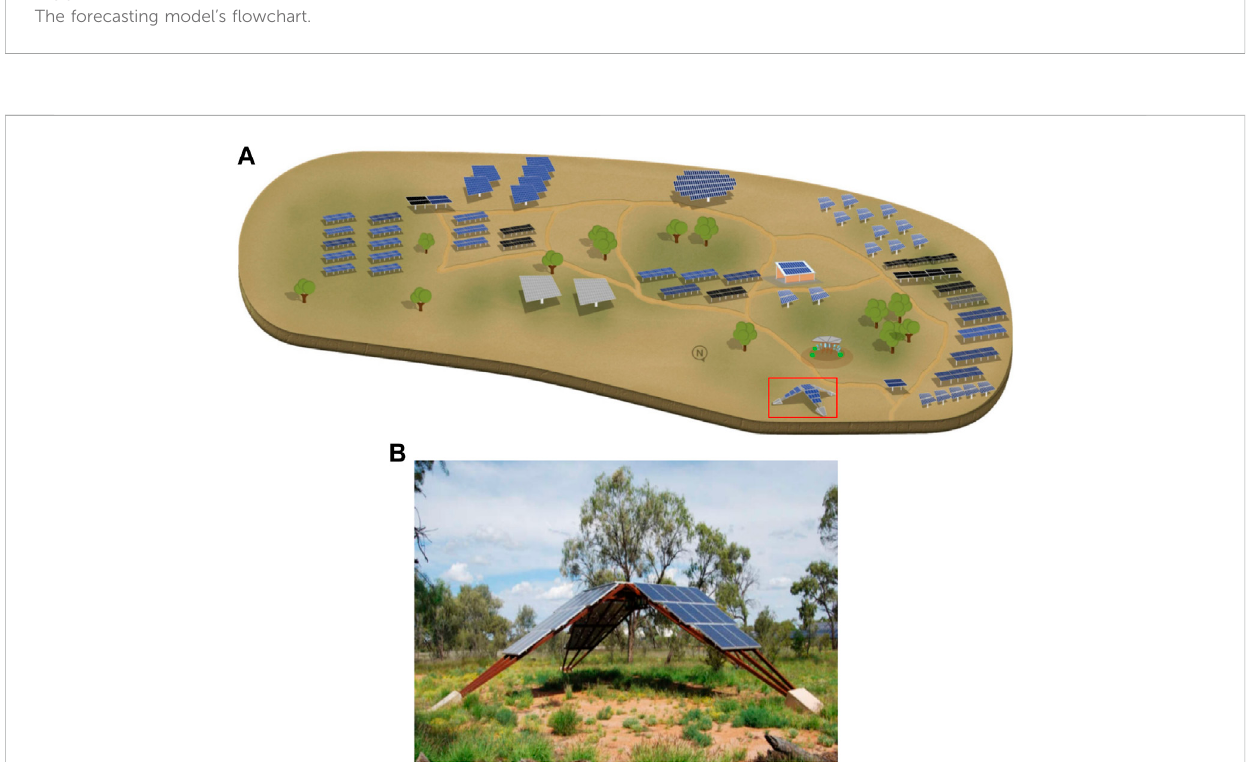
FIGURE 5 Schematic diagram of (A) DKASC Alice Springs PV power station, (B) 16A_BP_Solar PV array (DKASC,